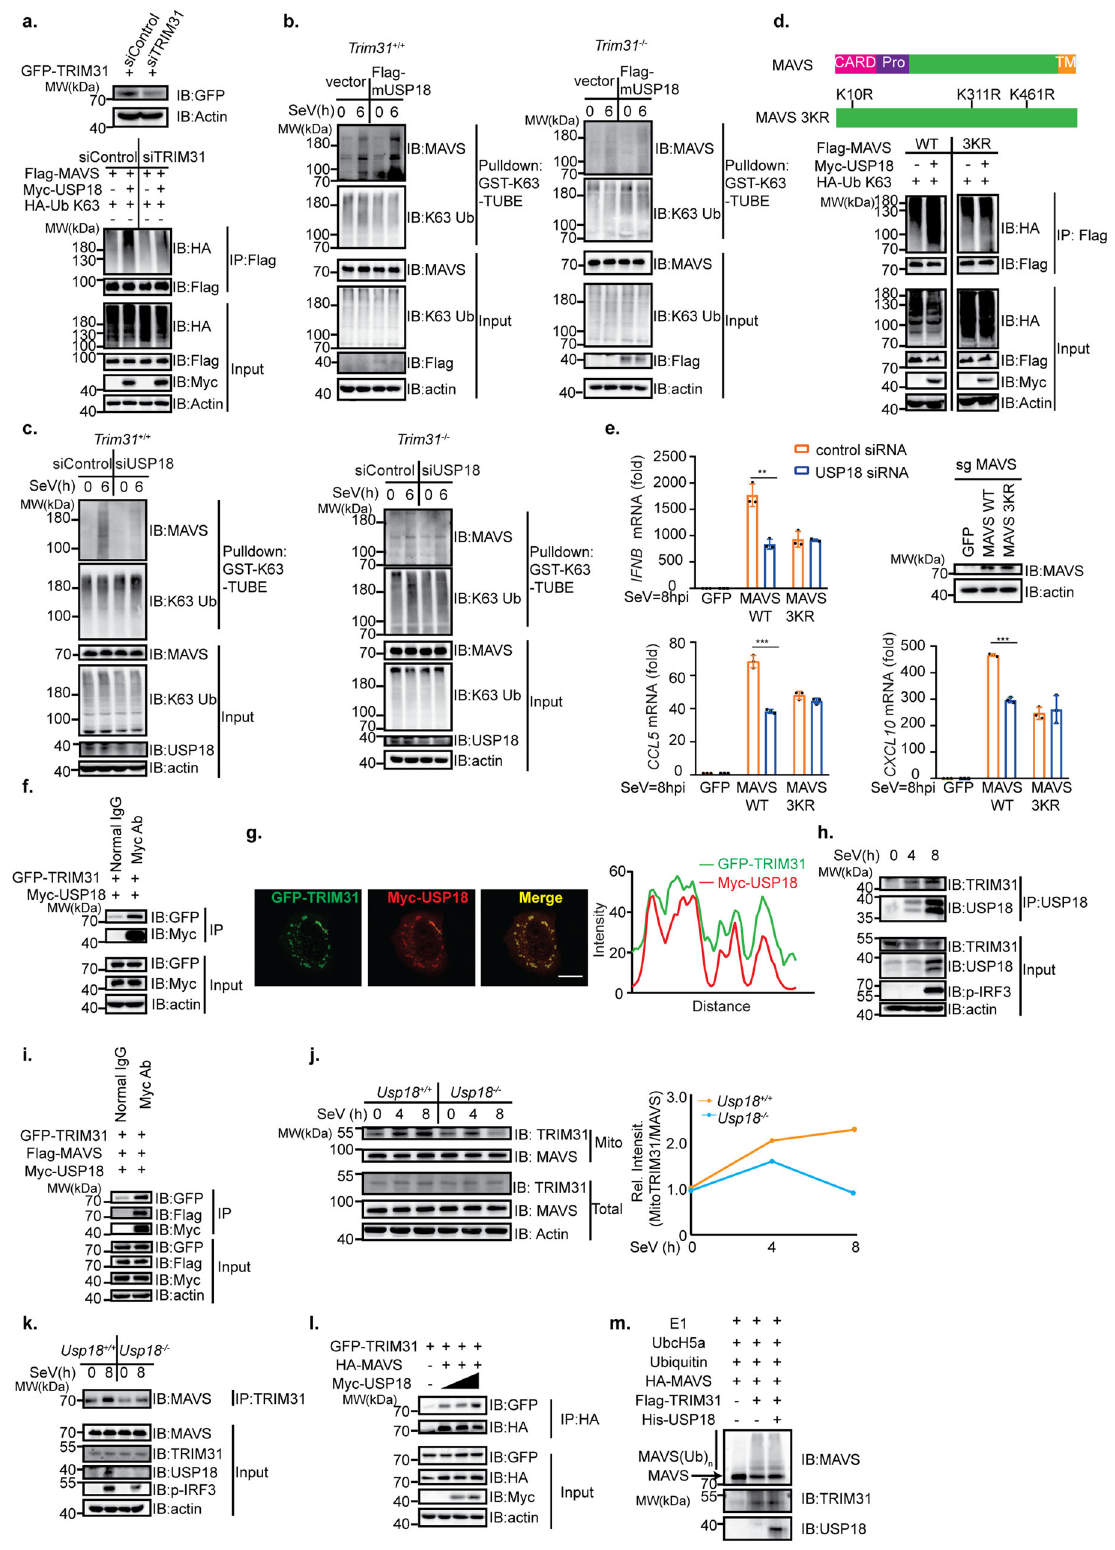
linked polyubiquitination of MAVS, which was supported by several scenarios. First, overexpression of ubiquitin linkage- speci fi c mutants and USP18 resulted in the enhanced K63-linked instead of K48-linked polyubiquitination. Second, the stability of MAVS was not changed in the presence or absence of USP18,